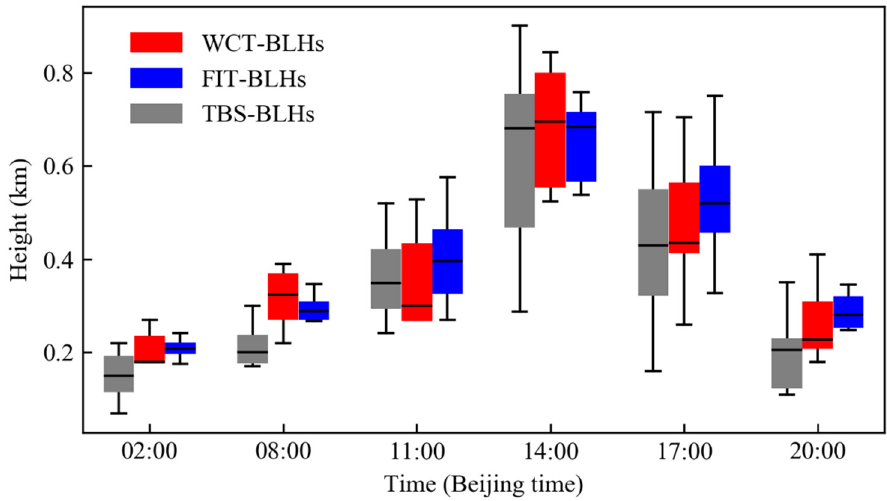
Figure 9. Diurnal variations in matched BLHs from lidar observations and TBS data.